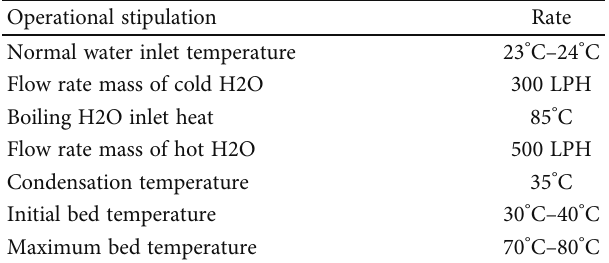
Table 2: Processing attributes of investigational study. Operational